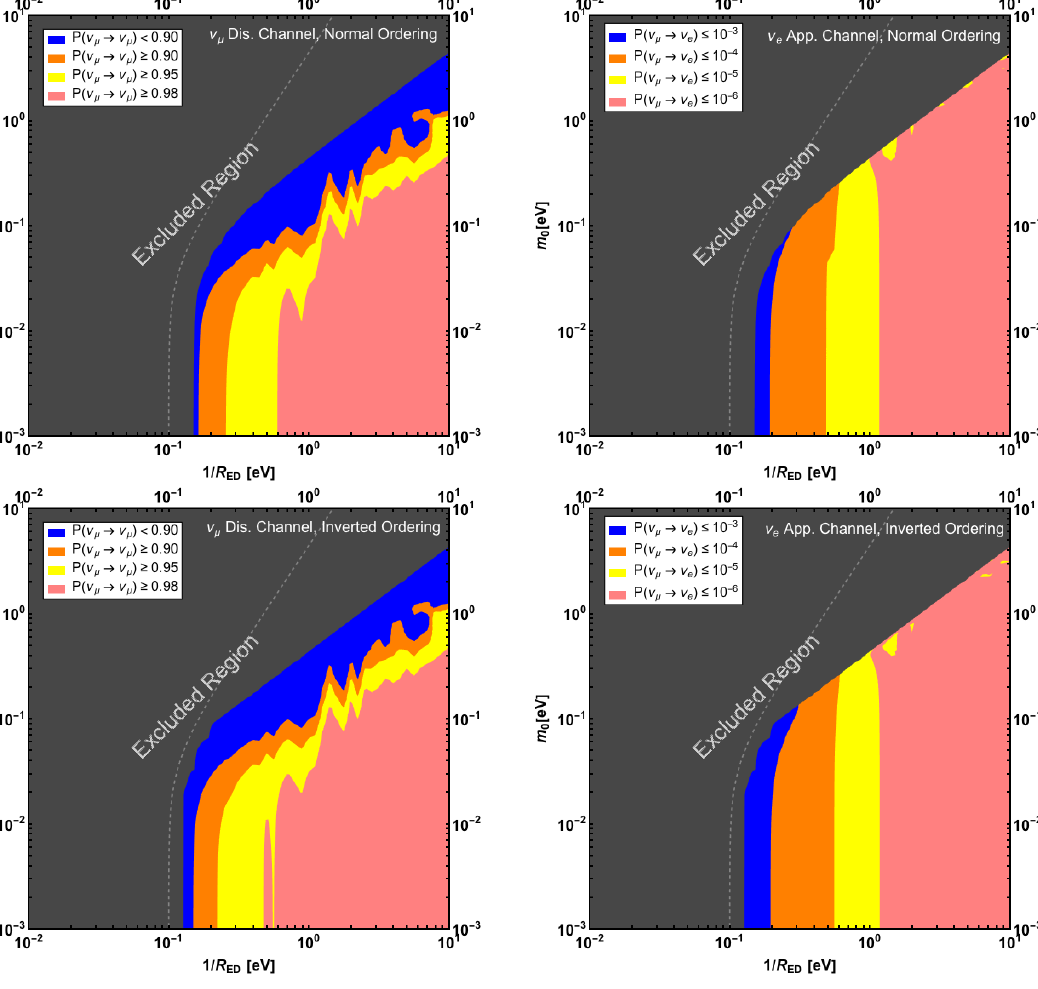
Figure 1 . Probability regions for di(cid:11)erent values of LED parameters, m 0 and R ED . In the left (right) panels we have (cid:23) (cid:22) ! (cid:23) (cid:22) ( (cid:23) (cid:22) ! (cid:23) e ). In the top (bottom) panel we show the normal (inverted) ordering. We chose here a typical short-baseline L=E (cid:23) of 1.2 km/GeV, see text for details, and we compute probabilities using the (cid:12)rst 40 KK modes. The gray shaded region is excluded due to neutrino oscillation data (see section